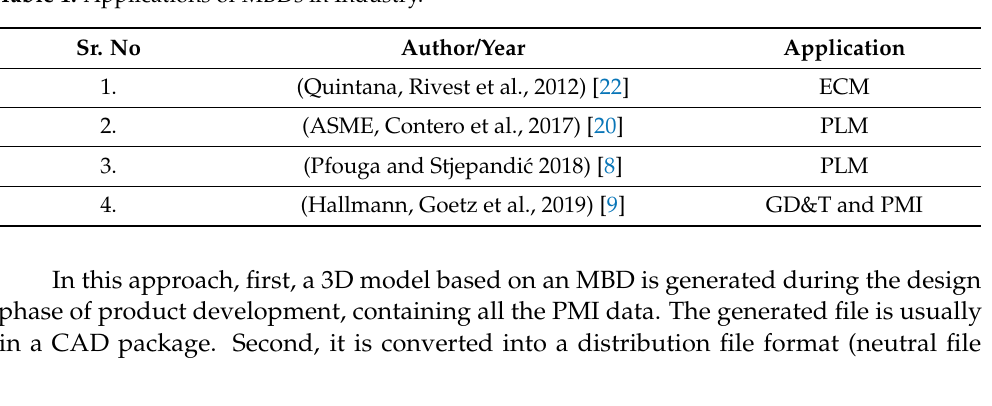
Table 1. Applications of MBDs in